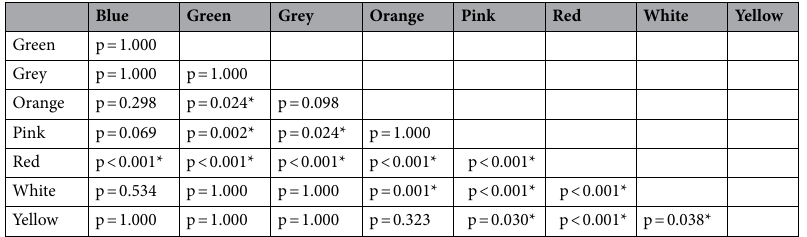
Blue Green Grey Orange Pink Red